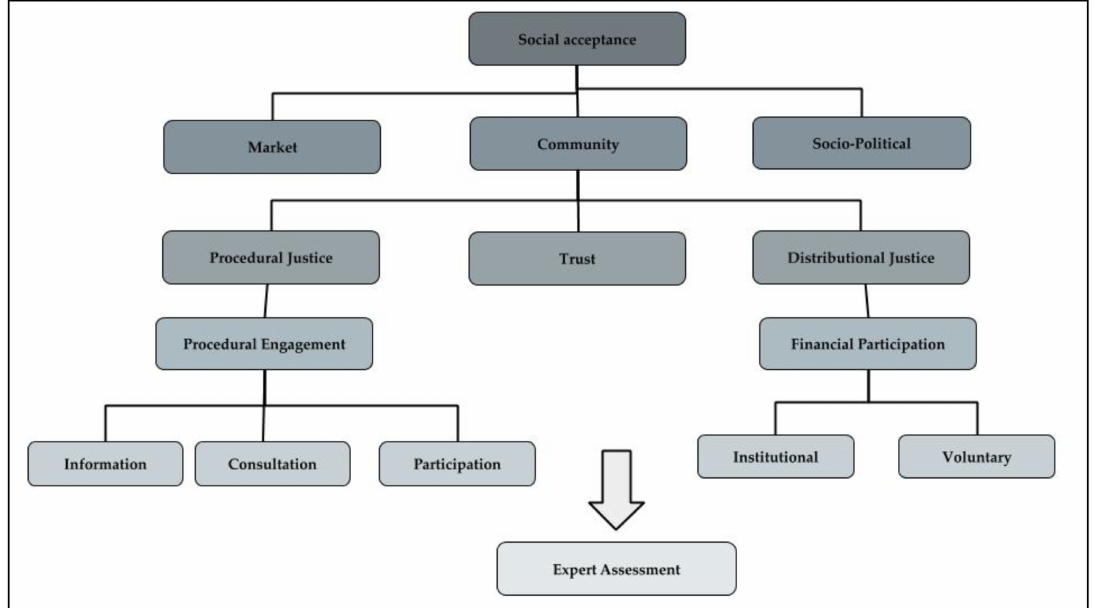
Figure 1. Dimensions of social acceptance, acceptance drivers and the related levels of public participation. Source: authors’